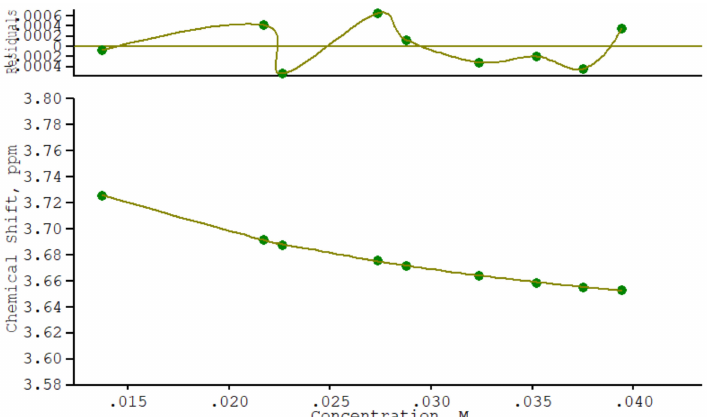
Figure 2. Proposed geometry of the β -CD/NTBC inclusion complex and a partial contour plot of the 2D-ROESY spectrum recorded for a 4:1 β -CD/NTBC ratio.